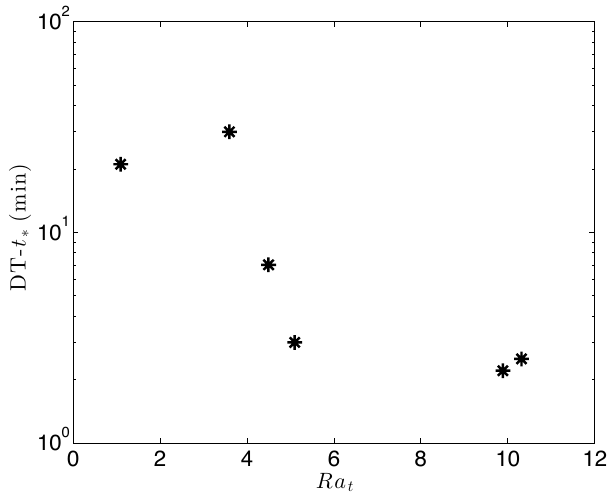
Figure 9. For all the IOPs, difference between the delay and con- vective times as a function of Ra t